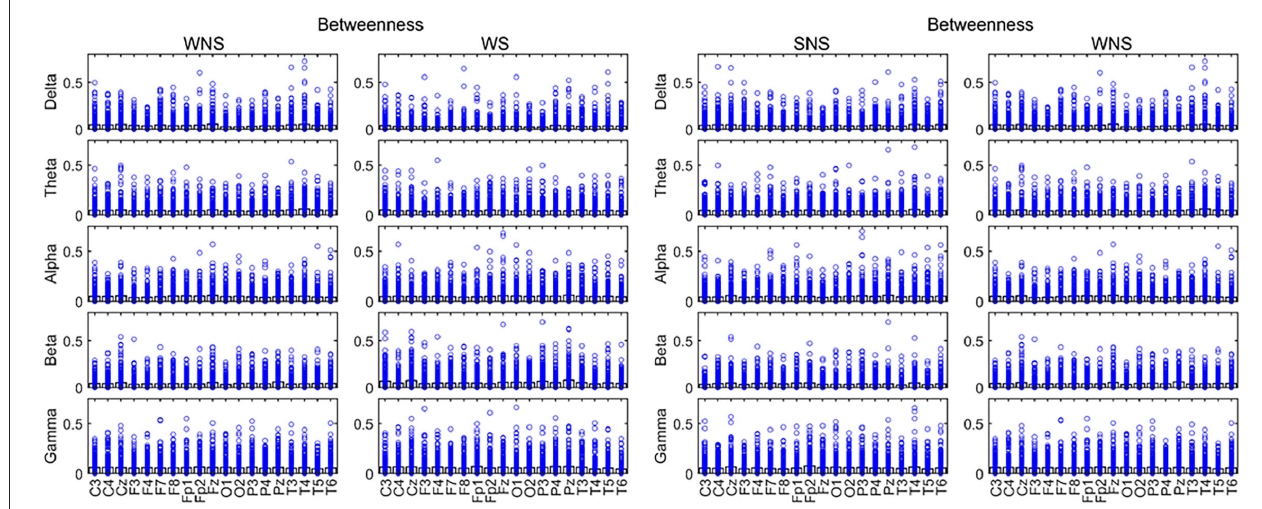
FIGURE 5 | Betweenness centrality (BC) in different frequency bands. Fast waves played more important roles in the centrality of the local network, especially in the forehead in the IS ictal phase ( P < 0.05). SNS, sleep period; WNS, awake period; WS, ictal period during waking.